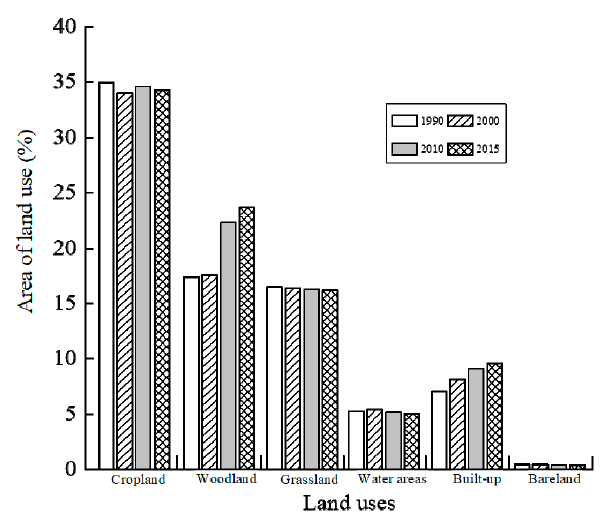
Figure 2. Areal changes in land uses from 1990 to 2015 in the Jing-Jin-Ji region.